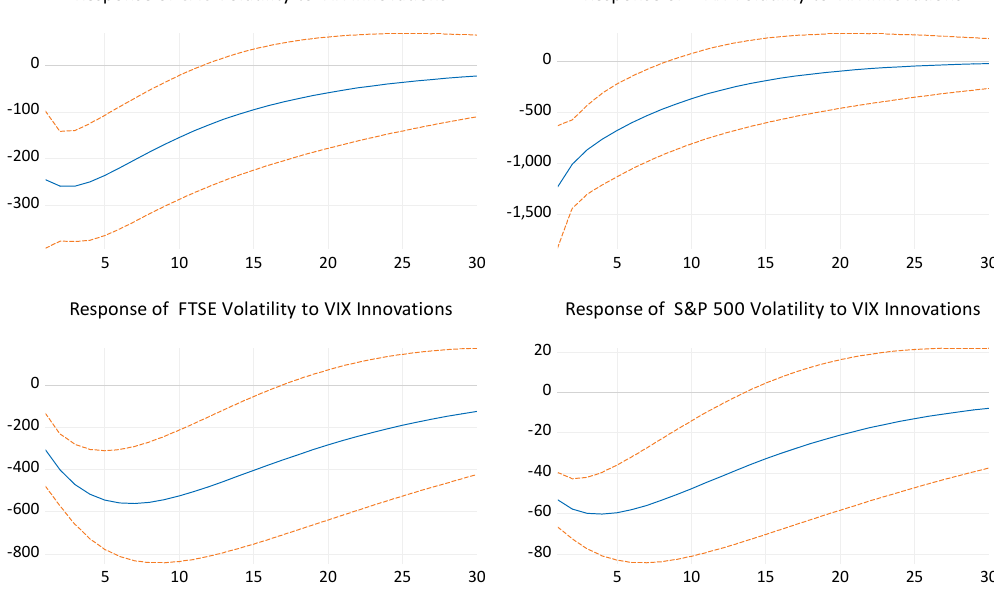
Figure 6. Responses of volatility in equity indices to structural innovations in VIX. Estimates and two standard deviation confidence band are in solid and dotted lines. SVAR lag order is one. 13 August 2015 − 17 May 2016.